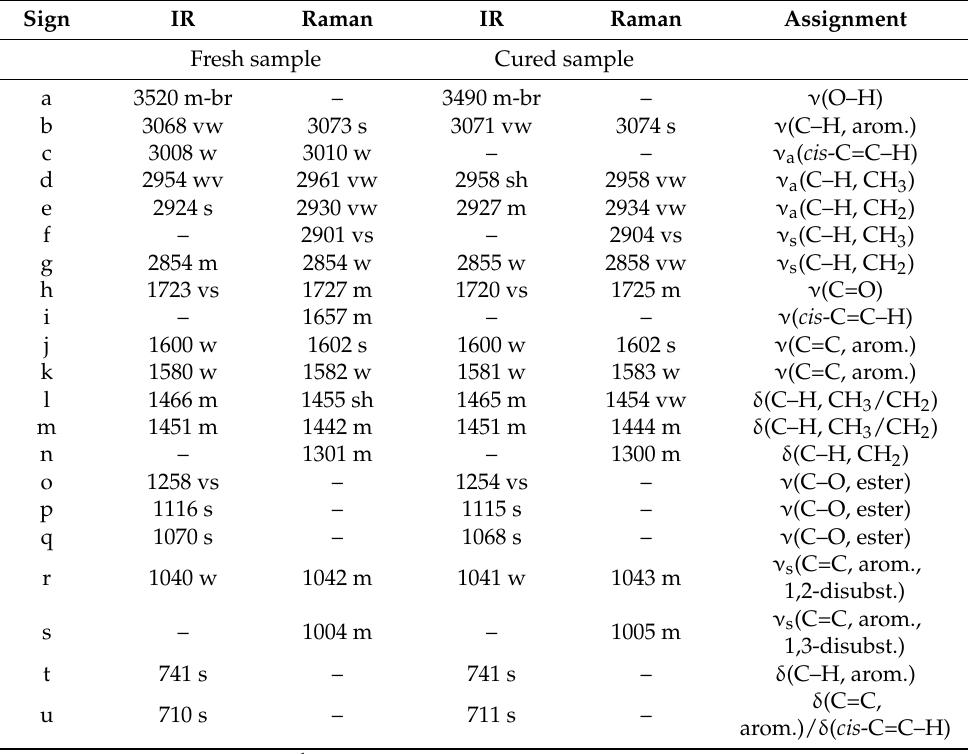
Table 4. Assigned characteristic vibration modes for binder S471 1 .